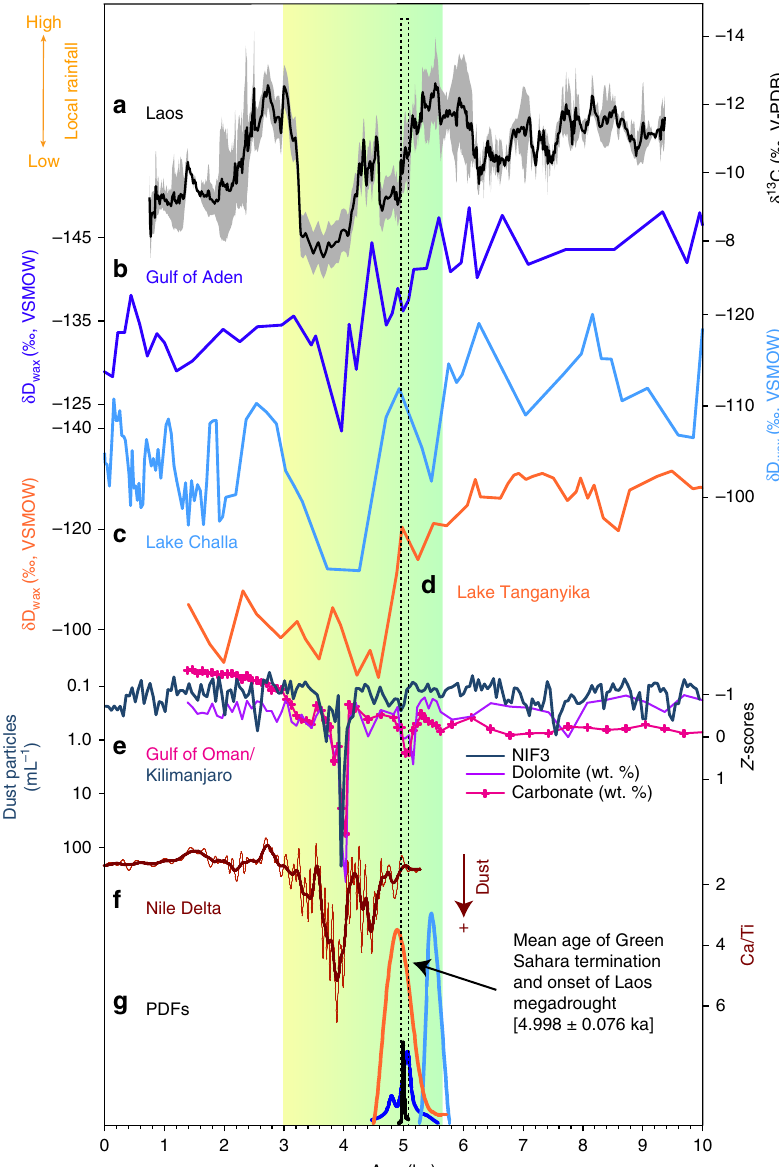
Fig. 3 Mainland southeast Asian hydroclimate and end of the Green Sahara. a Northern Laos composite δ 13 C record (black line) and 1 σ uncertainty (gray shading) from Tham Doun Mai speleothems. b – d δ D wax records from marine core P178 – 15P (Gulf of Aden) 3 , Lake Challa 40 , and Lake Tanganyika 41 . e Percent dolomite (light purple line) and carbonate (pink line) (expressed as standardized Z -scores) from the Gulf of Oman 33 . Also shown is the dust record (aquamarine line) from Mt. Kilimanjaro ice core KNIF3 38 . f Ca/Ti record of dust deposition in the Nile Delta 42 . g Color-coded (cyan: Lake Challa; orange: Lake Tanganyika; black: Tham Doun Mai; blue: Gulf of Aden) probability density function (PDF) output from the Bayesian change-point algorithm 39 . Vertical color bar indicates the transition from a wet to a dry Sahara between 5.5 and 3.5 ka 2,3